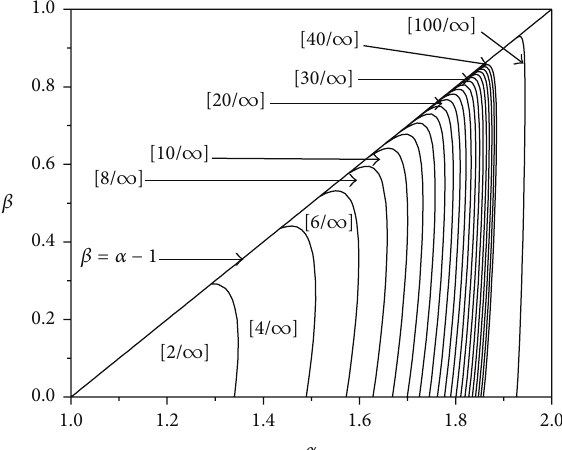
Figure 9: The lower region of [ 𝑓( even )/∞ ] showing subphases [ 𝑛/∞ ], 𝑛 = 2, 4, 6,8, . .. .